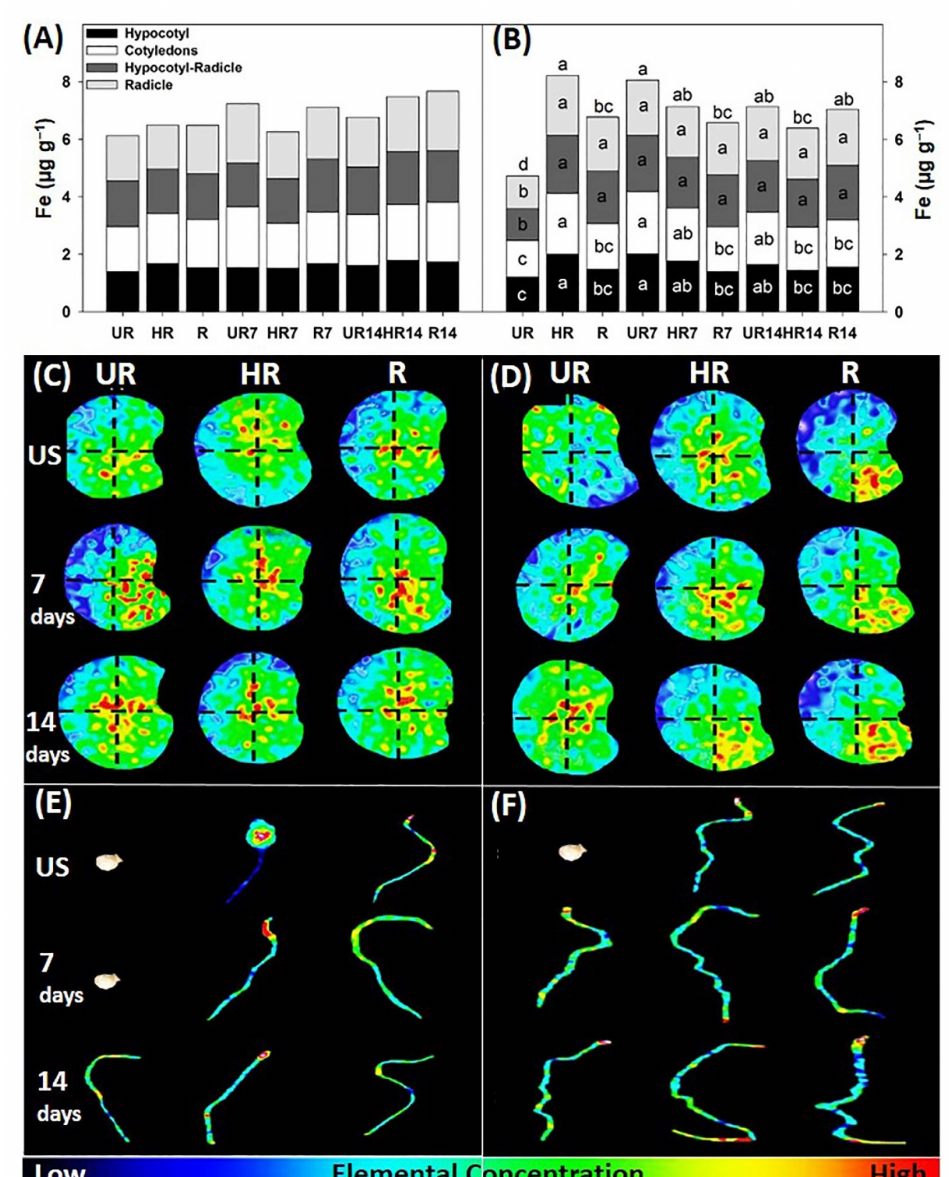
Figure 5. Fe concentration in seeds pre-imbibition ( A ) and post-imbibition ( B ), Fe distribution in habanero pepper seeds pre-imbibition ( C ) and post-imbibition ( D ), habanero seedlings at 10 ( E ) and 14 days ( F ) after sowing, of seeds of unripe (UR), half-ripe (HR), and ripe (R) fruits; unstored (US) and stored for 7 and 14 days postharvest. Colors in panels ( C – F ) are based on a relative intensity scale (reported at the bottom of the figure) generated on the intensity of the X-ray fluorescence K α peak of Fe in the samples. Data are means. Different letters indicate statistically significant differences among treatments (Duncan, p ≤ 0.05, n =